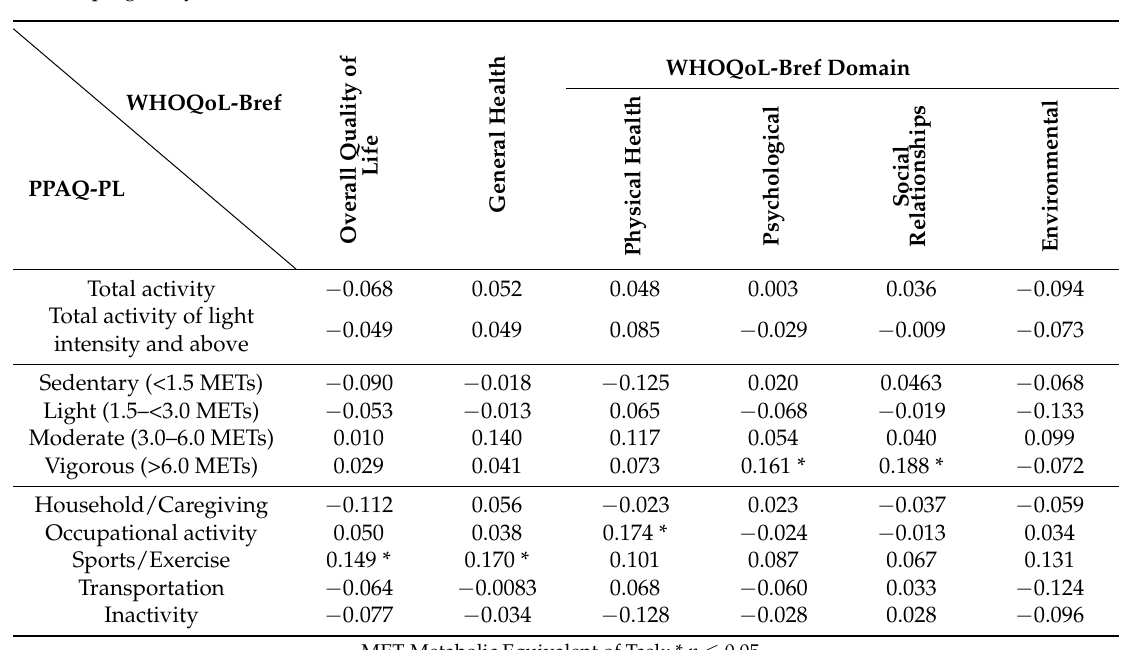
Table 4. Spearman’s correlation coefficients between the Pregnancy Physical Activity questionnaire (PPAQ-PL) and Quality of Life-Bref Questionnaire (WHOQoL-Bref) in women in the third trimester of